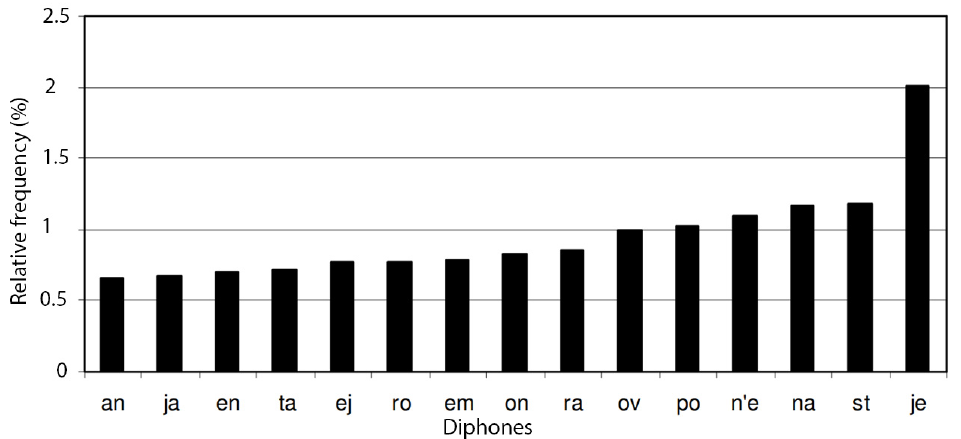
Figure 3. The 15 most common diphones. They account for 14.22% of all diphones in the final corpus.